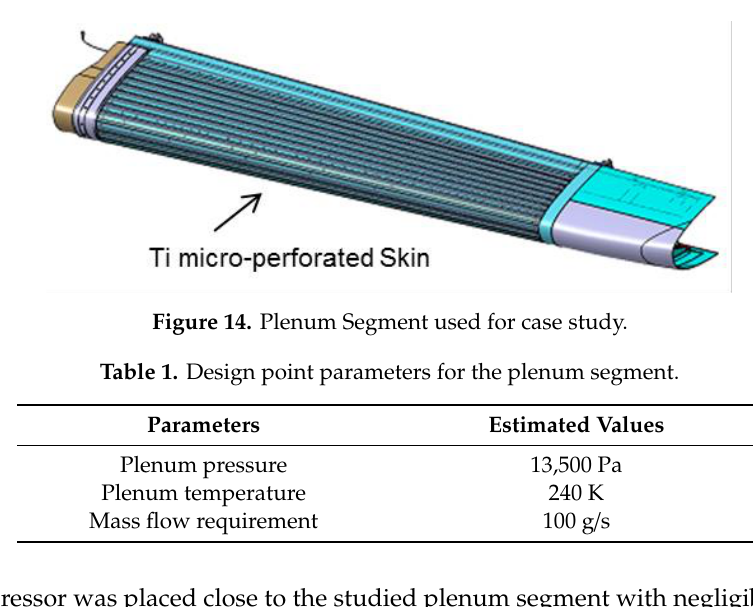
Figure 13. Components checked for space constraint in the digital mock-up: ( a ) Model compressor; ( b ) duct layout.